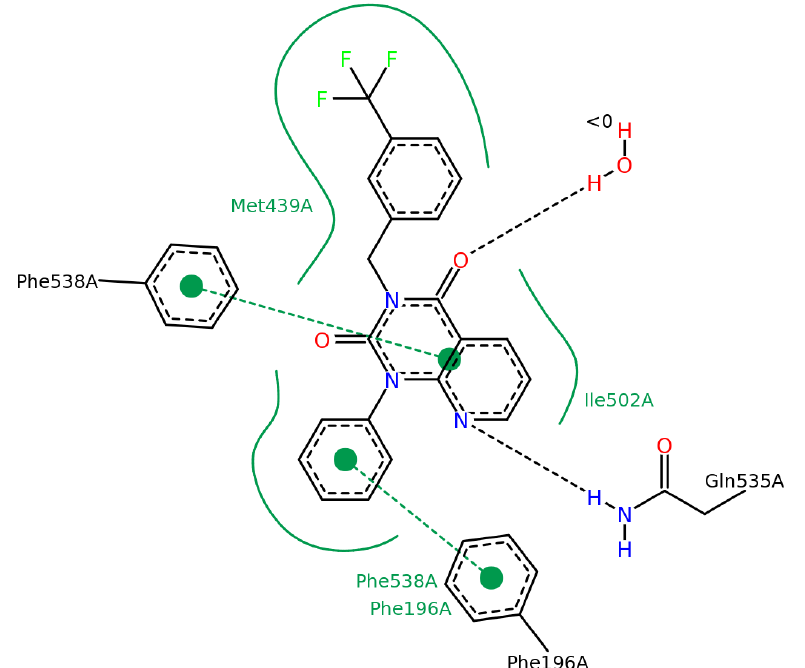
Figure 15. Diagram of the most important interactions in the Glide XP calculated PDE4D—#3 (2nd round hit) complex identified by PoseView. Black dashed lines represent hydrogen bonds, green solid lines represent hydrophobic interactions and green dashed lines represent aromatic interactions.